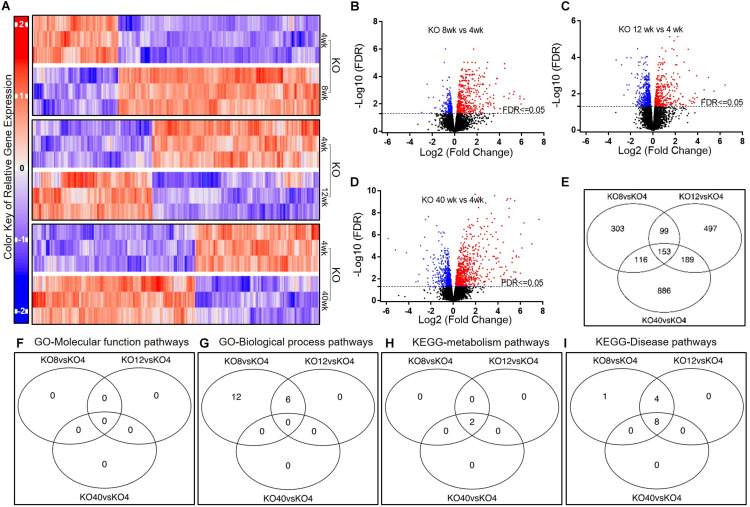
Gene expression in AMs from Scgb1a1 KO mice across age groups. (A) Up-regulated and down-regulated genes in AMs at 4, 8, 12, and 40 weeks; (B–D) Volcano plots of significantly up-regulated (red) and down-regulated (blue) genes (FDR < 0.05); (E) Venn diagrams of the significantly changed genes. Venn diagrams of the significantly changed gene sets in AMs from KO mice at different ages including GO-Molecular function pathways (F), GO-Biological process pathways (G), KEGG-metabolism pathways (H), and KEGG-Disease pathways (I). FDR < 0.05 was considered significant; FC, fold change.